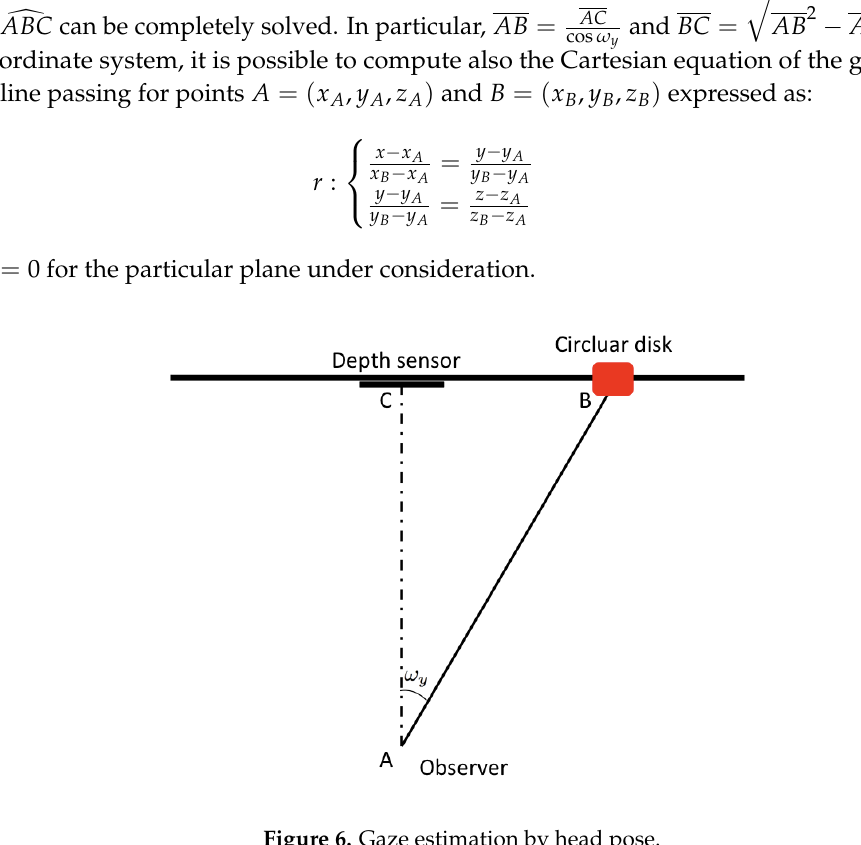
Figure 6. Gaze estimation by head